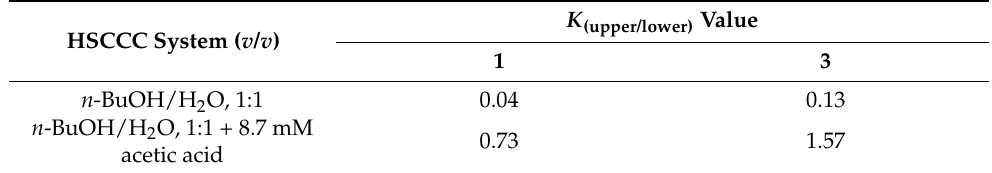
Figure 3. Chromatograms of pH-zone-refining CCC separation and HPLC detection of the target compounds from the 70% MeOH extract of V. rigida root. ( A ) pH-zone-refining CCC separation of the target compounds 1–7 from the extract using solvent system EtOAc/ n -BuOH/H 2 O (2:3:5, v / v ). The upper phase of EtOAc/ n -BuOH/H 2 O (2:3:5, v / v ) was acidified using formic acid (208 mM) as the stationary phase, whereas the lower phase of EtOAc/ n -BuOH/H 2 O (2:3:5, v / v ) was basified using ammonia (30 mM) as the mobile phase. Revolution speed: 800 rpm; mobile phase flow rate: 4 mL/min; UV detection wavelength 254 nm. ( B ) HPLC chromatograms (254 nm) of the 70% MeOH extract of V. rigida root and the compounds separated from it by pH-zone-refining CCC. Notably, compound 8 was obtained by its natural crystallization in the remaining stationary phase collected after separation. Table 3. Modification of the solvent system by adding acetic